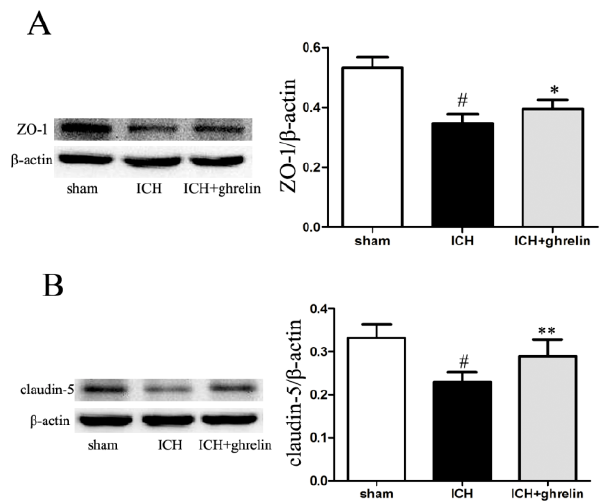
Figure 3. Ghrelin alleviated the disruption of intestinal tight junction after ICH. ( A ) Zonula occludens-1 (ZO-1) protein expression was significantly decreased after ICH compared with the sham group. After ghrelin administration, the ZO-1 protein expression was upregulated post-ICH; ( B ) Claudin-5 protein levels were downregulated in the ICH group compared to the sham group; however, ghrelin increased the protein level of claudin-5 after ICH. The values are the mean ± SD, n = 6, # p < 0.01 vs. sham group; * p < 0.05 vs. ICH group; ** p < 0.01 vs. ICH group. The data are representative of six independent experiments performed in triplicate.